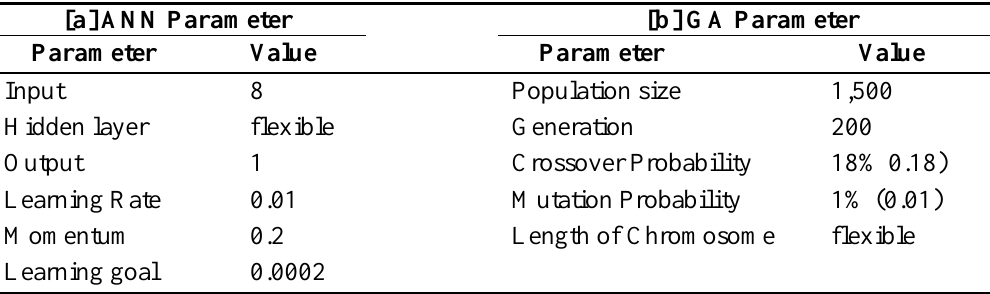
Table 2. Parameters used in the